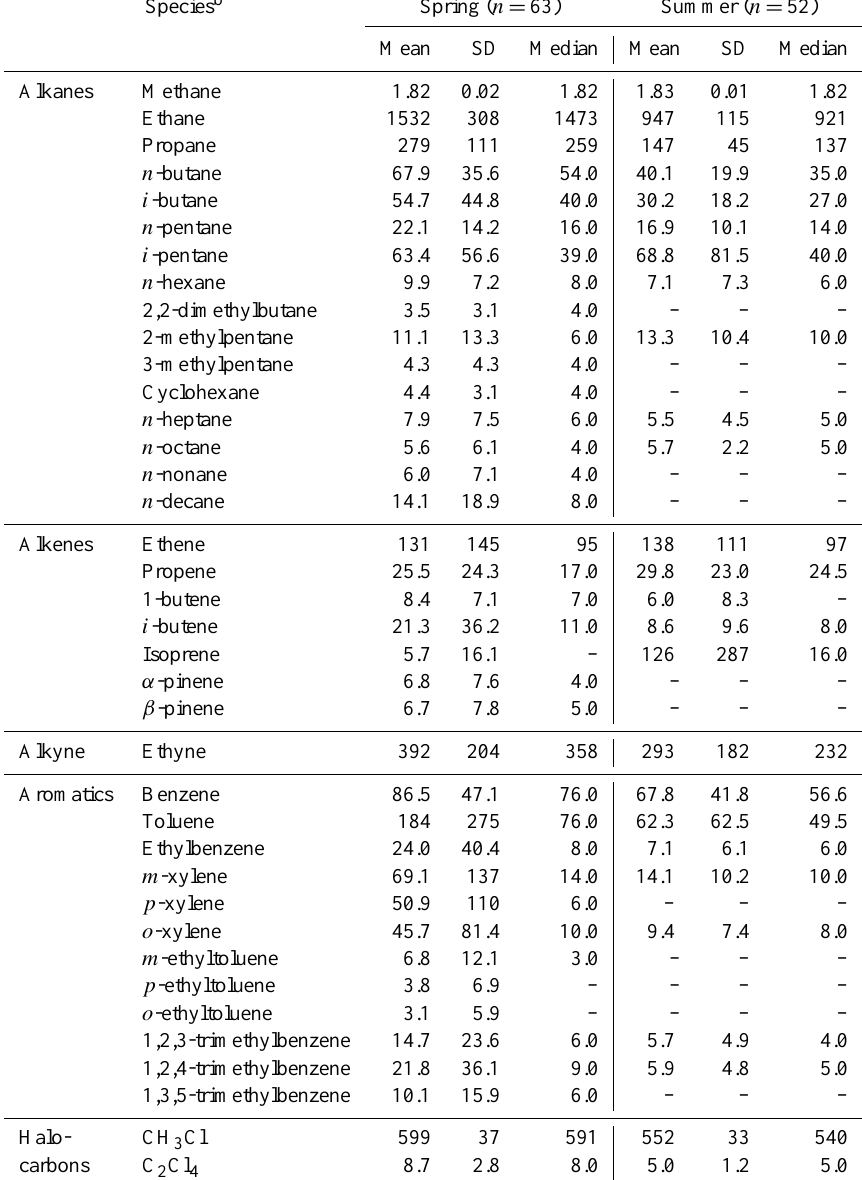
Table 1. Statistics of major VOC species measured at WLG a